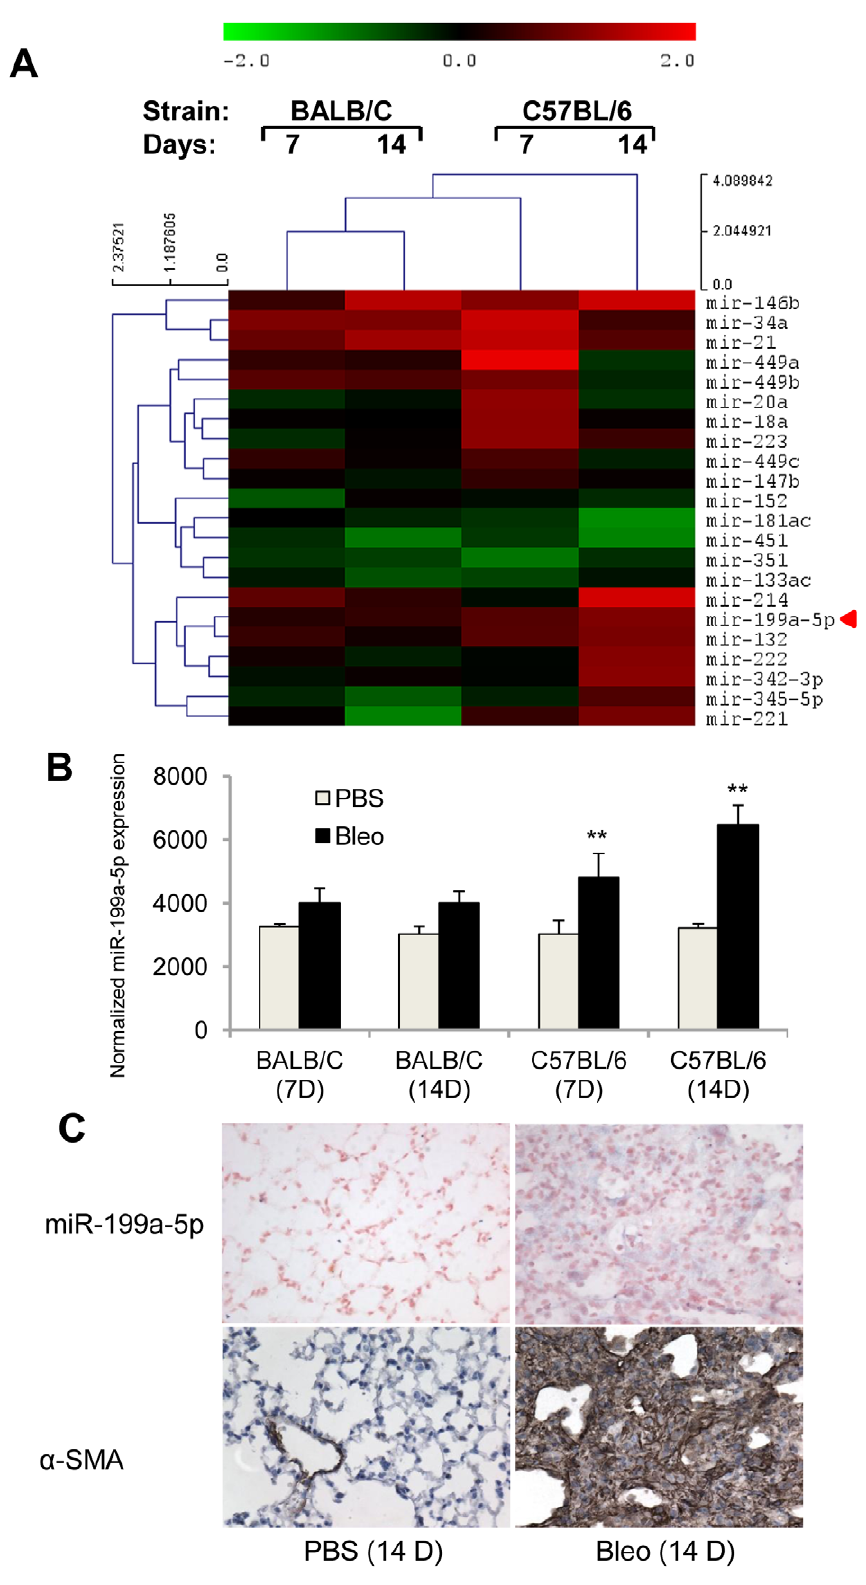
Figure 1. miR-199a-5p expression during bleomycin induced lung fibrosis. (A) Heat map representing the statistically significant (adjusted p-value , 0.05) differentially expressed microRNAs in lungs from BALB/C and C57BL/6 mice in response to bleomycin at the indicated time points. Up- regulated microRNAs are shown in progressively brighter shades of red, depending on the fold difference, and down-regulated microRNAs are shown in progressively brighter shades of green. miR-199a-5p is marked in red. n=3 mice in each group. (B) miR-199a-5p expression in lungs from BALB/C